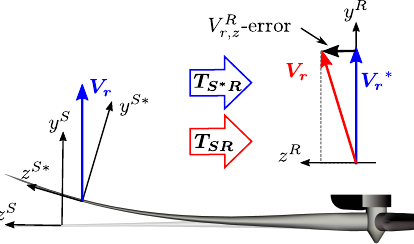
Figure 11. The rotation angle of the deflected blade section is un- known in the current method. An error is thereby introduced when mapping the measured wind speed, V r , from the blade-section to the rotating-rotor coordinates using the transformation matrix, T SR . The result is a constant error in the z R direction that leads to sinu- soidal oscillations of the x and z components of the estimated free wind speed seen in Fig. 10.